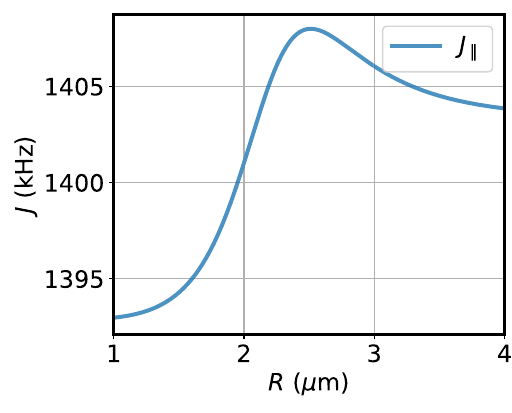
FIG. 10. The J (cid:8)